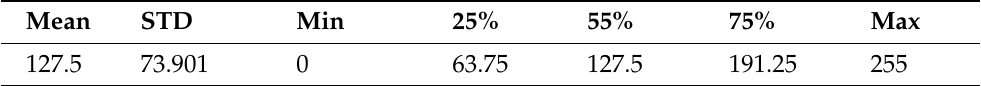
Table 4. Ideal statistics of an image with uniformly distributed pixels.